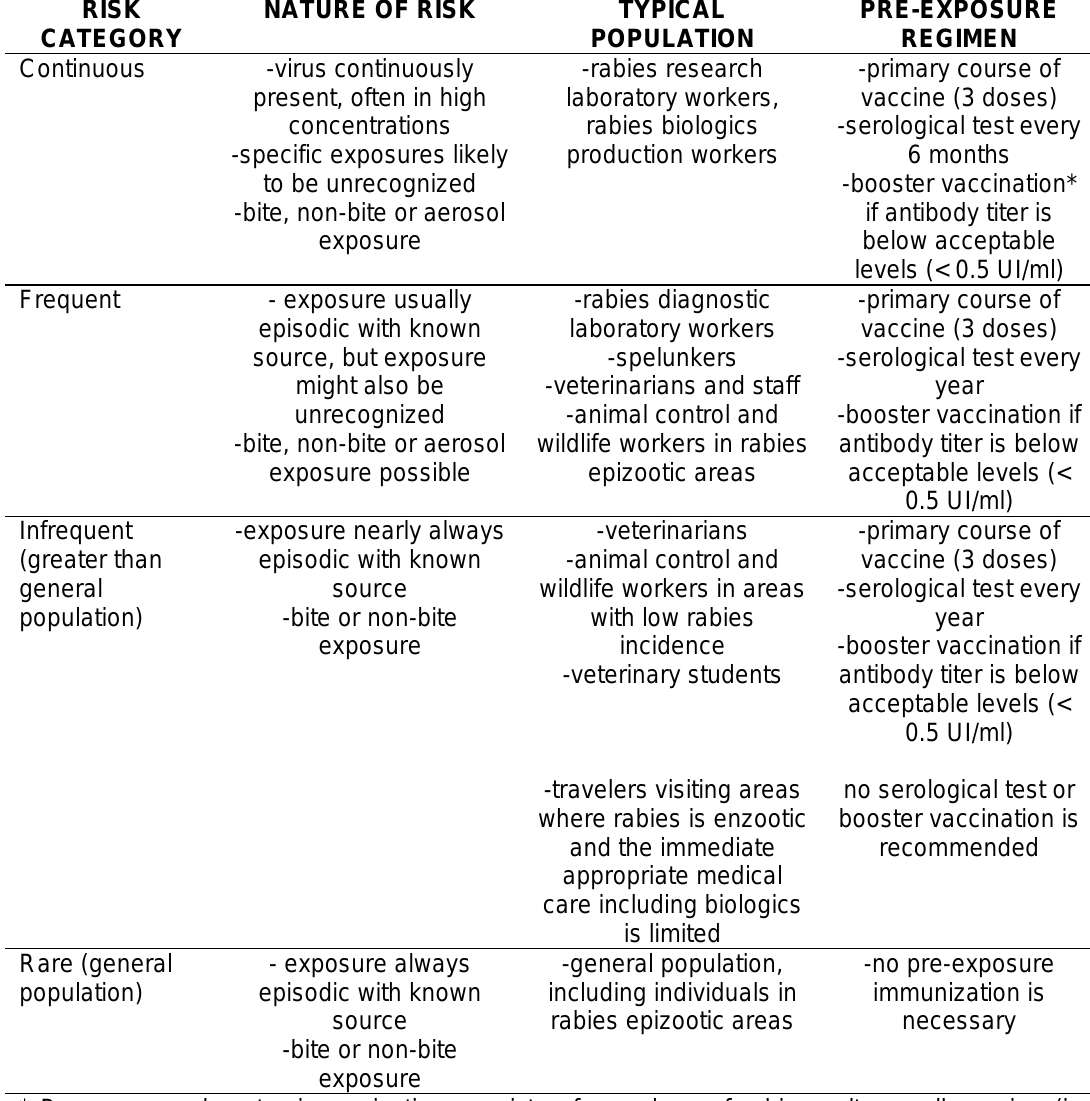
* Pre-exposure booster immunization consists of one dose of rabies culture cell vaccine (in Brazil, Vero cell rabies vaccine) injected into the deltoid area by intramuscular (0.5 ml) or intradermal (0.1 ml)